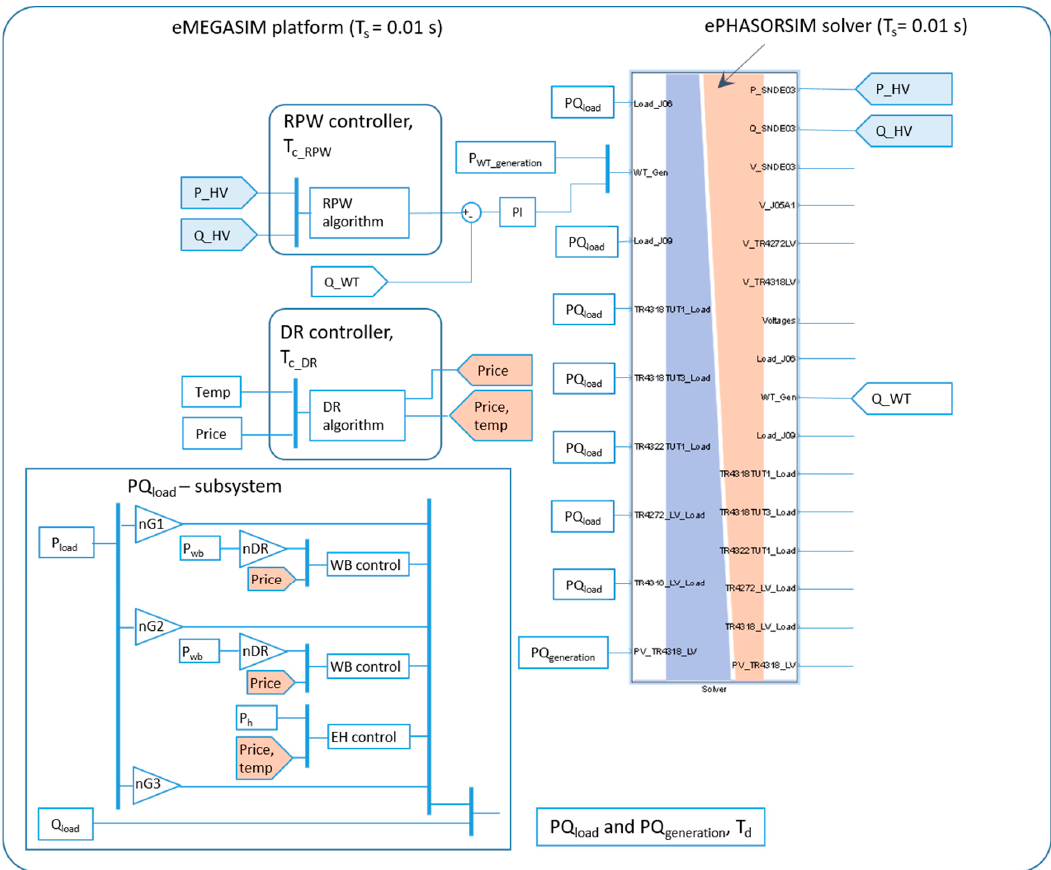
Figure 14. The simulation architecture for the emulated power system and the